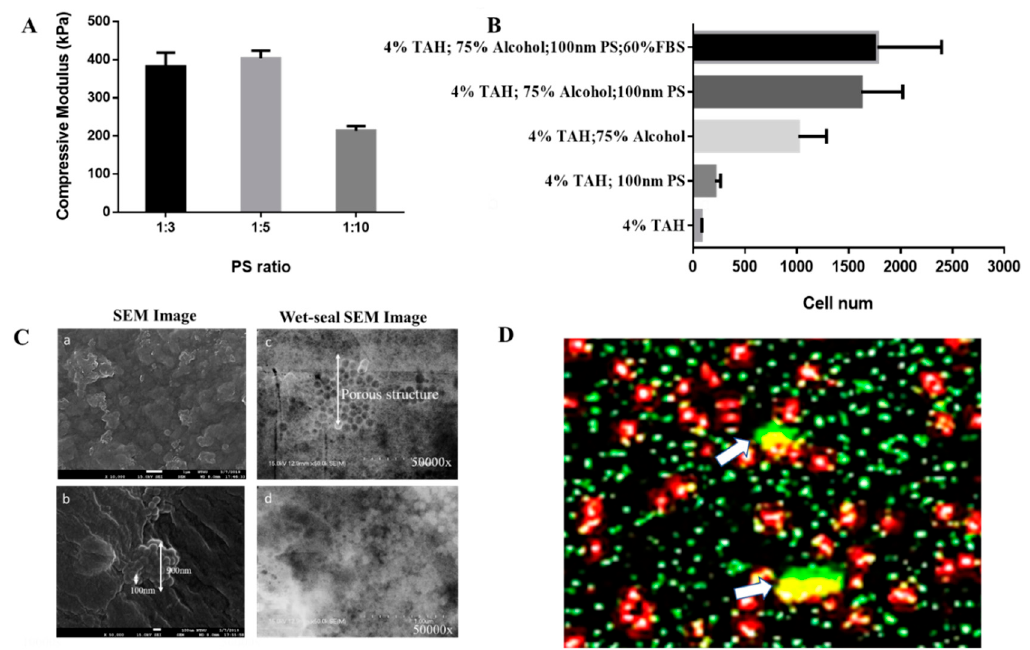
Figure 5. The effect of nanotopographical density on cell homing. ( A ) The compressive modulus of 4% alginate hydrogel mixed with PS nanoparticles in different ratios: 1:3, 1:5 and 1:10, where the ratio of 1:5 showed the greatest stiffness. ( B ) The number of MCF-7 cells attached on the surface of TAH pre-treated with different conditions. In the groups of TAH treated with 75% ethanol and PS nanoparticles resulted in better cell homing. ( C ) The surfaced structure of hydrogel doped by 100 nm PS nanoparticles was scrutinized by SEM and wet SEM. The magnification of (a) was 10,000× and others were 50,000×. ( D ) The overlaid image of MCF-7 cells attached on TAH / 75% ethanol / PS beads was recorded by confocal microscopy. The ratio of total area of PS nanoparticles (green) to cell covering area (red) was 0.045.